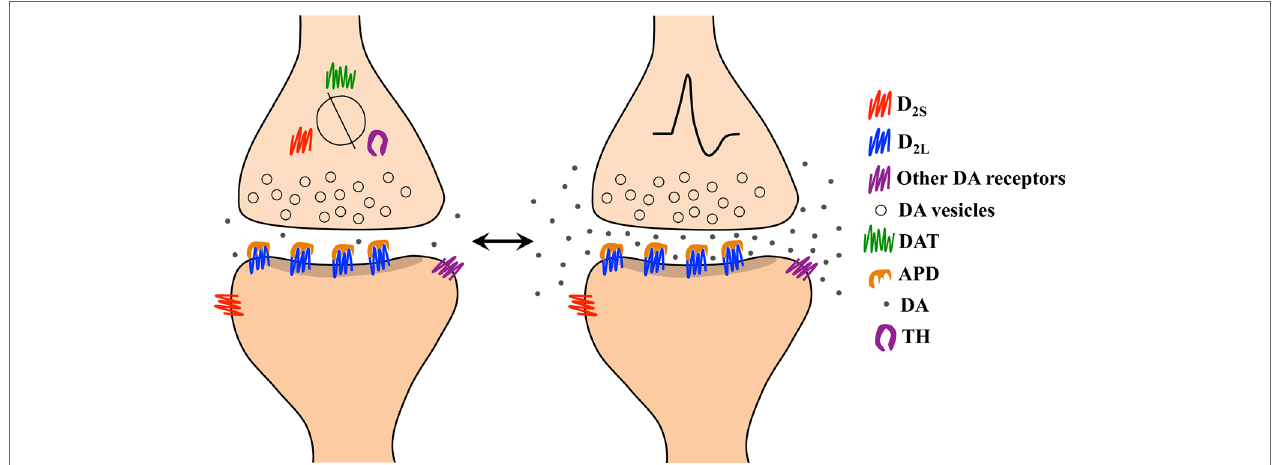
FIGURE 4 | Representation of the pharmacological mechanism underlying the absence of therapeutic response in antipsychotic-resistant schizophrenia based on our model. (Left) Aging and/or addictive drugs consumed before antipsychotic treatment begins (i.e., in first episode psychosis) lead to reduced expression of the dopamine transporter (DAT), D 2 autoreceptors, and tyrosine hydroxylase (TH), as these proteins appear to be co-regulated, at least in rodents. (Right) During environmentally evoked phasic dopamine release, impaired capacity for autoinhibition results from low levels of DAT and D 2 autoreceptors. The resulting post- synaptic stimulation contributes to psychosis despite a significant blockade of D 2 receptors by antipsychotic drugs